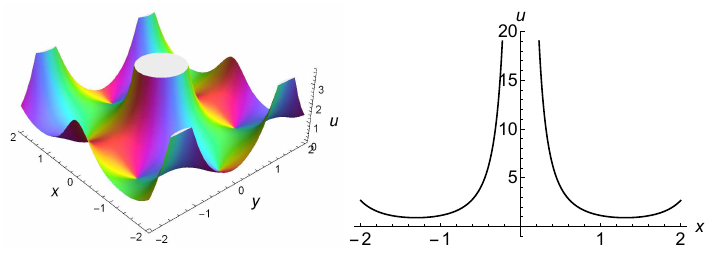
Figure 4. The 3D and 2D solution profiles of (34).